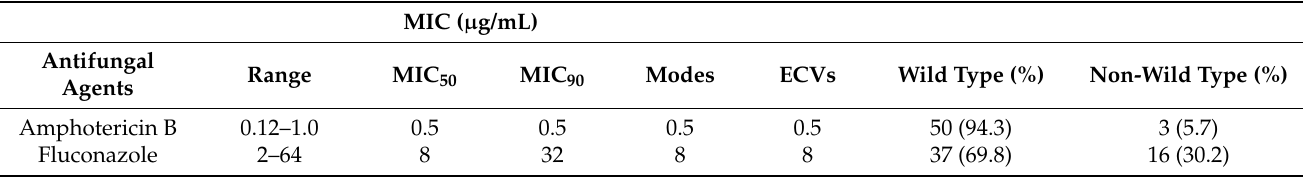
Table 2. Distribution of the minimal inhibitory concentrations of antifungal agents among 53 crypto- coccal meningitis CSF